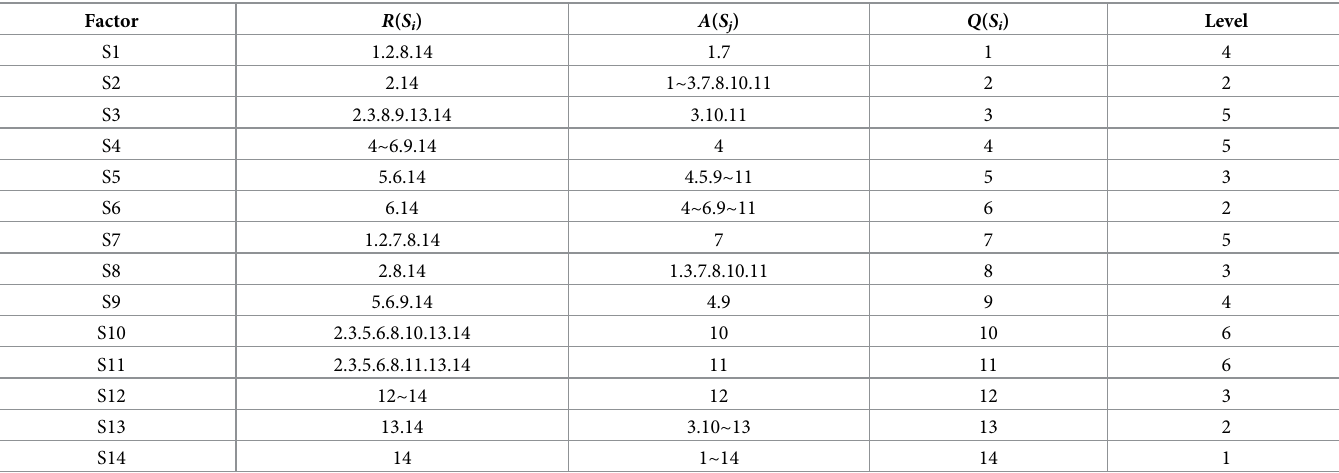
Table 7. Reachable set, antecedent set and common set.